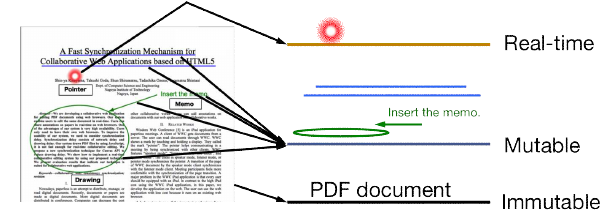
Fig. 1. The Three Types of Canvas